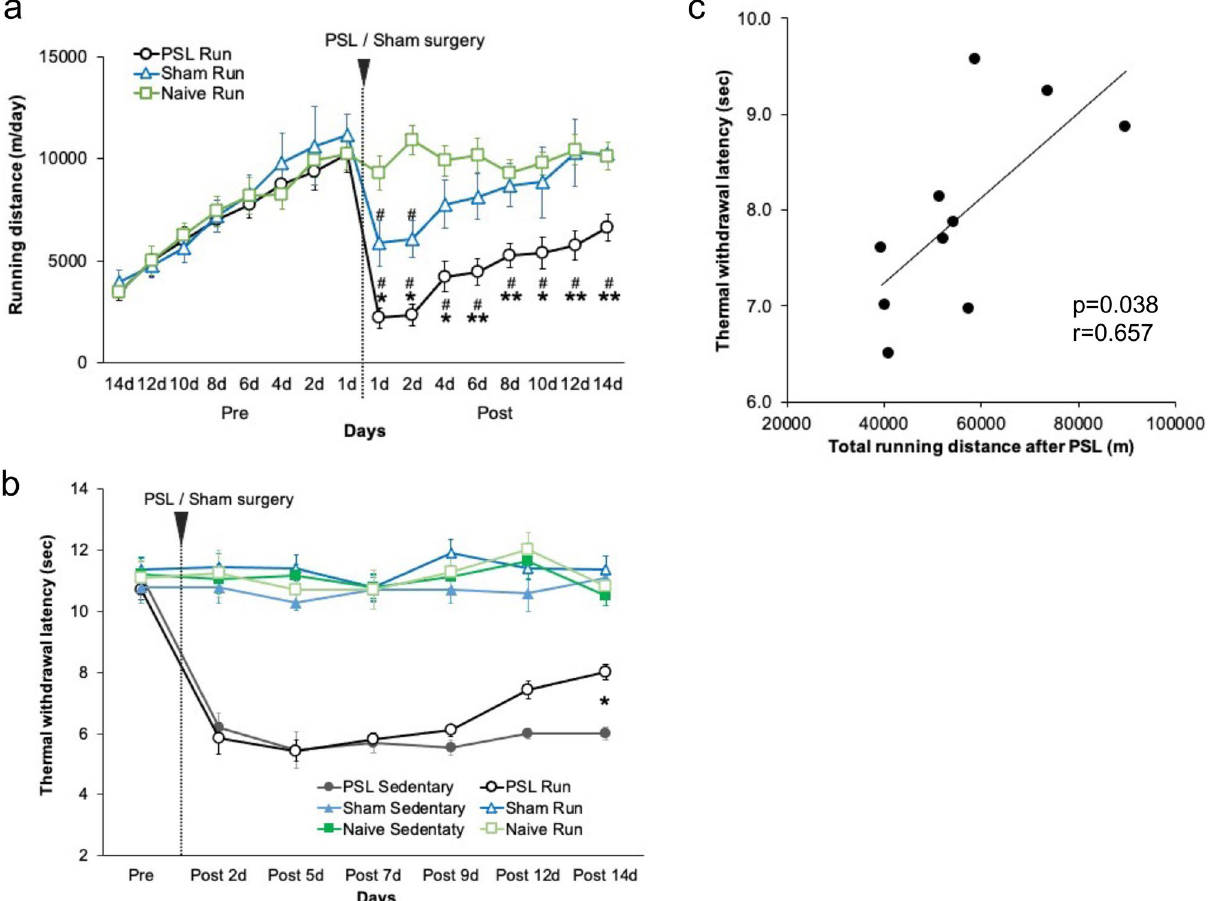
Figure 2. Changes in running distances and pain thresholds during the experimental period. ( a ) Changes in running distances in the three Runner groups before and after surgery (n = 9–10). Running distances of PSL-Runner mice gradually increased after PSL surgery. Data represent the mean ± SEM. A two-way repeated measures analysis of variance followed by Tukey’s post-hoc test was used to compare the Running distance among PSL-/Sham-/Naive-Runner groups. *p < 0.05, **p < 0.01, compared to Sham-Runner mice. # p < 0.01, compared to Naive-Runner mice. ( b ) Thermal withdrawal latencies were significantly higher in PSL-Runner mice than in PSL-Sedentary mice at days 14 post-surgery. Data represent mean ± SEM. A three-way repeated measures analysis of variance followed by Tukey’s post-hoc test was used to compare the withdrawal latencies among all experimental groups. *p < 0.01, PSL-Runner mice compared to PSL-Sedentary mice (n = 9–10). ( c ) Relationship between thermal withdrawal latency and total running distance after PSL surgery in PSL-Runner mice. A significant positive correlation was observed between the two variables (p = 0.038, r = 0.657, n = 10). PSL partial sciatic nerve ligation, SEM standard error of the